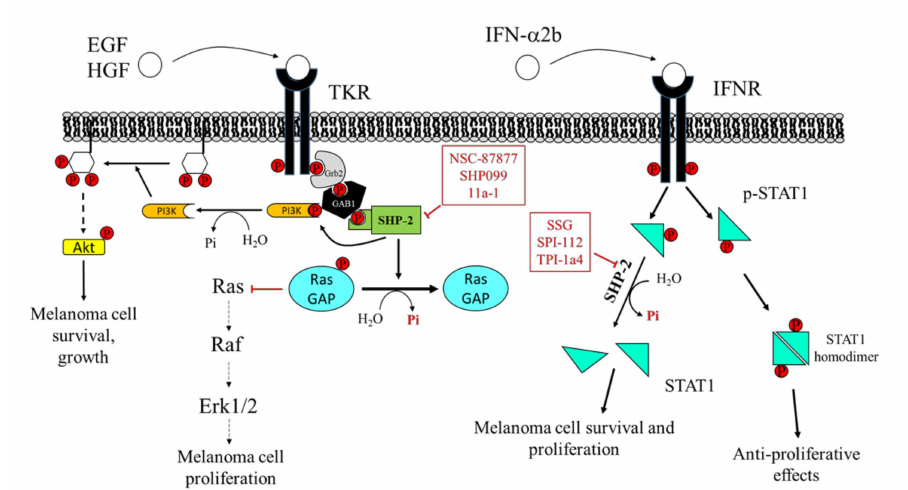
Figure 4. E ff ects of Src Homology Region 2 Domain-Containing Phosphatase-2 (SHP-2) targeting on melanoma cells. Left: SHP-2 has a key role in promoting the proliferation and survival of melanoma cells. SHP-2 dephosphorylates RasGAP, an inhibitor of Ras. Therefore, SHP-2, by activating Ras, promotes the RAS / RAF / ERK1 / 2 pathway, which sustains melanoma cell proliferation. Right: SHP-2 dephosphorylates GRB2-associated-binding protein 1 (GAB1), which releases PI3K, promoting activation of the PI3K / AKT pathway, melanoma cell growth, and survival. NSC-87877 and SHP099 inhibit SHP-2, impairing melanoma cell proliferation. SHP-2 also has an important role in regulating signaling activated by IFN- α 2b. SHP-2 dephosphorylates STAT1, hindering its dimerization and its migration into the nucleus, where it stimulates the transcription of several genes, resulting in melanoma cell growth arrest. Overexpression of SHP-2 in melanoma cells blunts the response to IFN- α , favoring melanoma cell survival and dissemination. SSG, SPI-112, and TPI-1a4 are potent inhibitors of SHP-2, enhancing the anti-proliferative activity of IFN- α